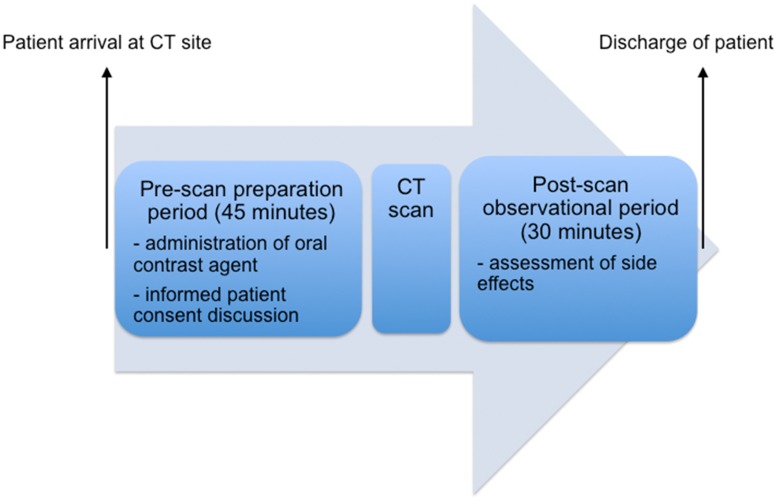
Timeline of the visit of a patient undergoing (thoraco-) abdominal staging CT.After arrival at the CT site, patients received 1 liter of an oral neutral contrast agent and were instructed to drink the full amount within 45 minutes prior to image acquisition. After completion of the CT scan, patients remained in the department over a period of 30 minutes for observational purposes and assessment of potential side effects.